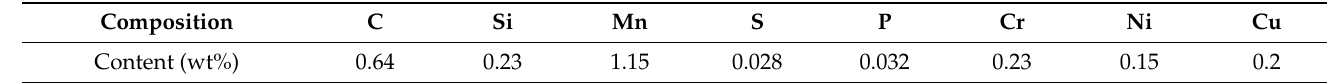
Figure 1. Knife: ( a ) macro-morphology of the silage knife after cladding; ( b ) cross-section morphology of the knife’s edge after cladding. Table 1. 65 Mn chemical composition of the matrix